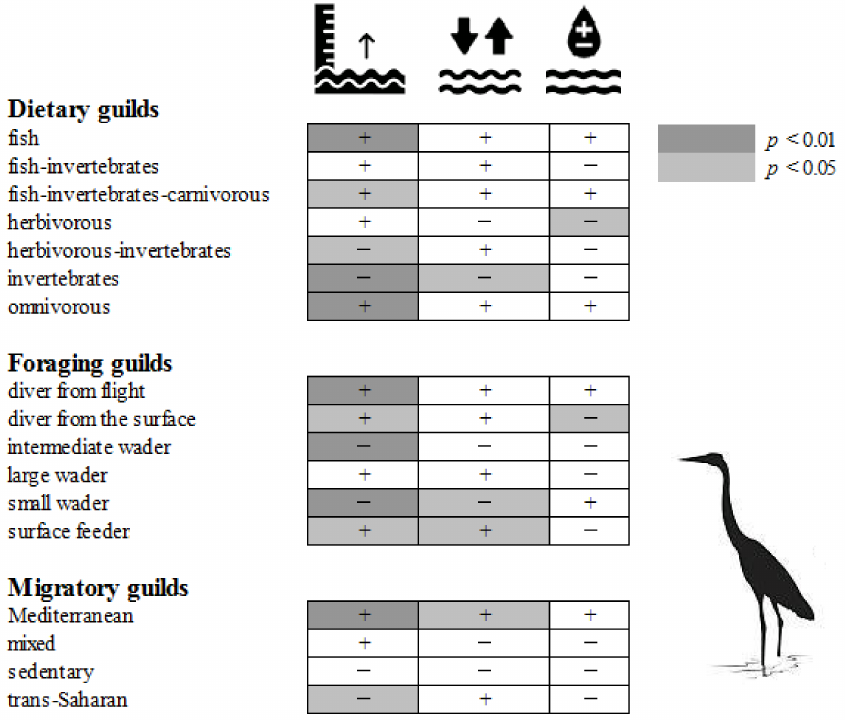
Figure 4. Results of the fourth-corner analysis. The negative or positive effects of the hydrological variables (in order from left to right: mean water level, water-level fluctuations, salinity) on the species guilds are shown. See Table S3 for a detailed description of species